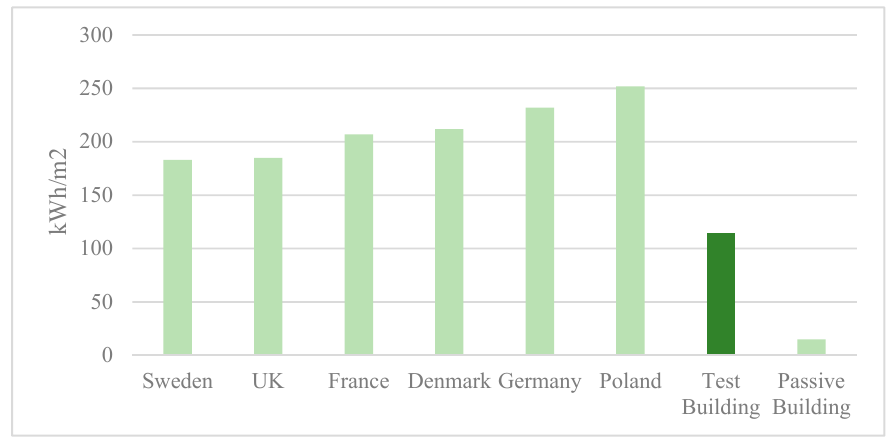
Figure 23. Heating energy consumption of the demonstration building and buildings in several